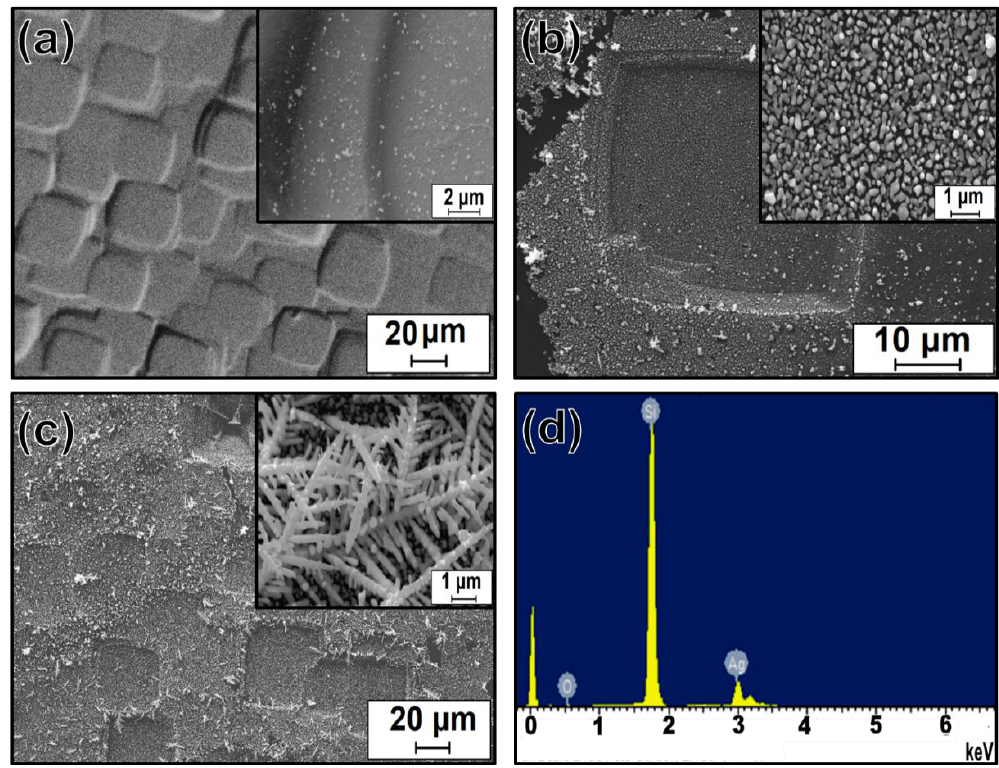
Figure 2. SEM images of Ag nanoparticles deposited on the unpolished side of the Si wafer for time periods ( a ) 30 s; ( b ) 60 s; ( c ) 120 s (Insets: higher magnification SEM); ( d ) EDX analysis of Ag nanoparticle deposited (60 s) Si wafer .